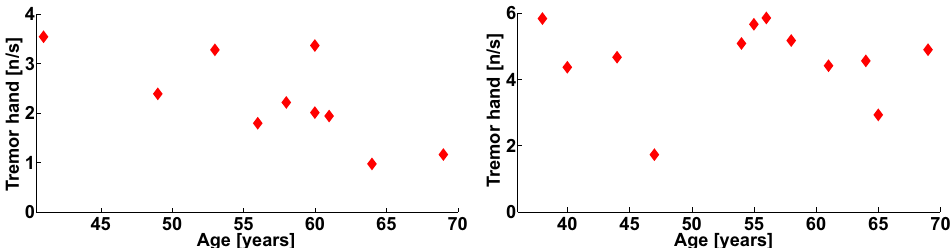
Figure 23. The scatter plot of the numbers of wave trains per second detected in the physiological tremor frequency band in the extensor muscle of the tremor arms of the PD patients. The scatter plot demonstrates the relation between the wave train number and the age of the patients. On the left, the left hands of the patients are shown. On the right, the right hands of the patients are